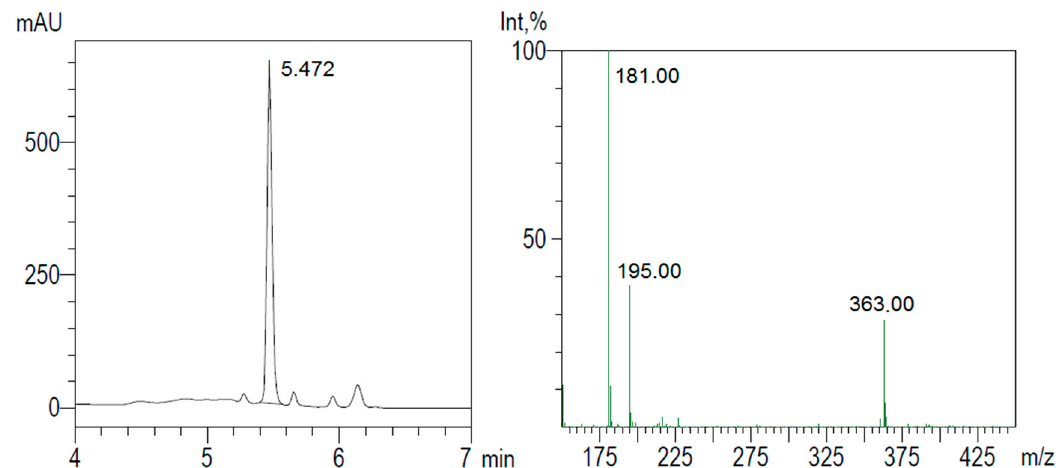
Figure 4. HPLC-MS analysis of 3-(2,4-dihydroxyphenyl)-propionic acid bioconversion mixture in vitro. UV 254 nm trace of 3-(2,4-dihydroxyphenyl)-propionic acid and its hydroxylated product under the same peak with retention time 5.472 min (on the left), and MS spectrum of the dominant peak (on the right). The negative ions [M − H] − generated are at m / z 181 (3-(2,4-dihydroxyphenyl)-propionic acid), 195 (product of 3-(trihydroxyphenyl)-propionic acid autooxidation), and 363 (dimer of 3-(2,4-dihydroxyphenyl)-propionic acid).